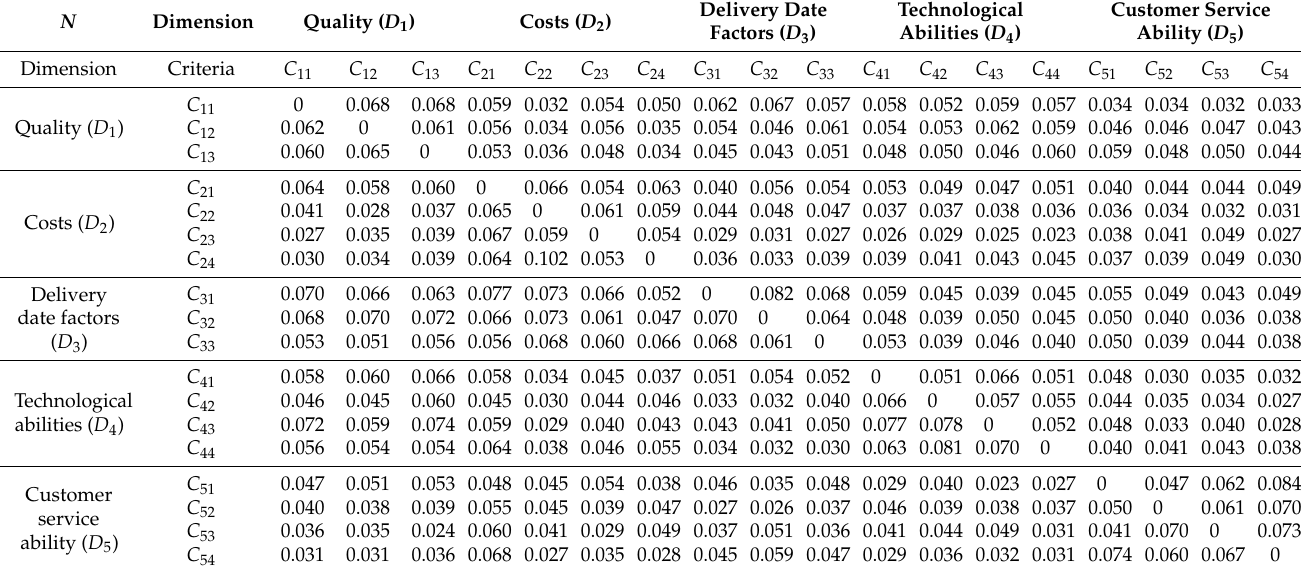
Table 5. Normalized relationship